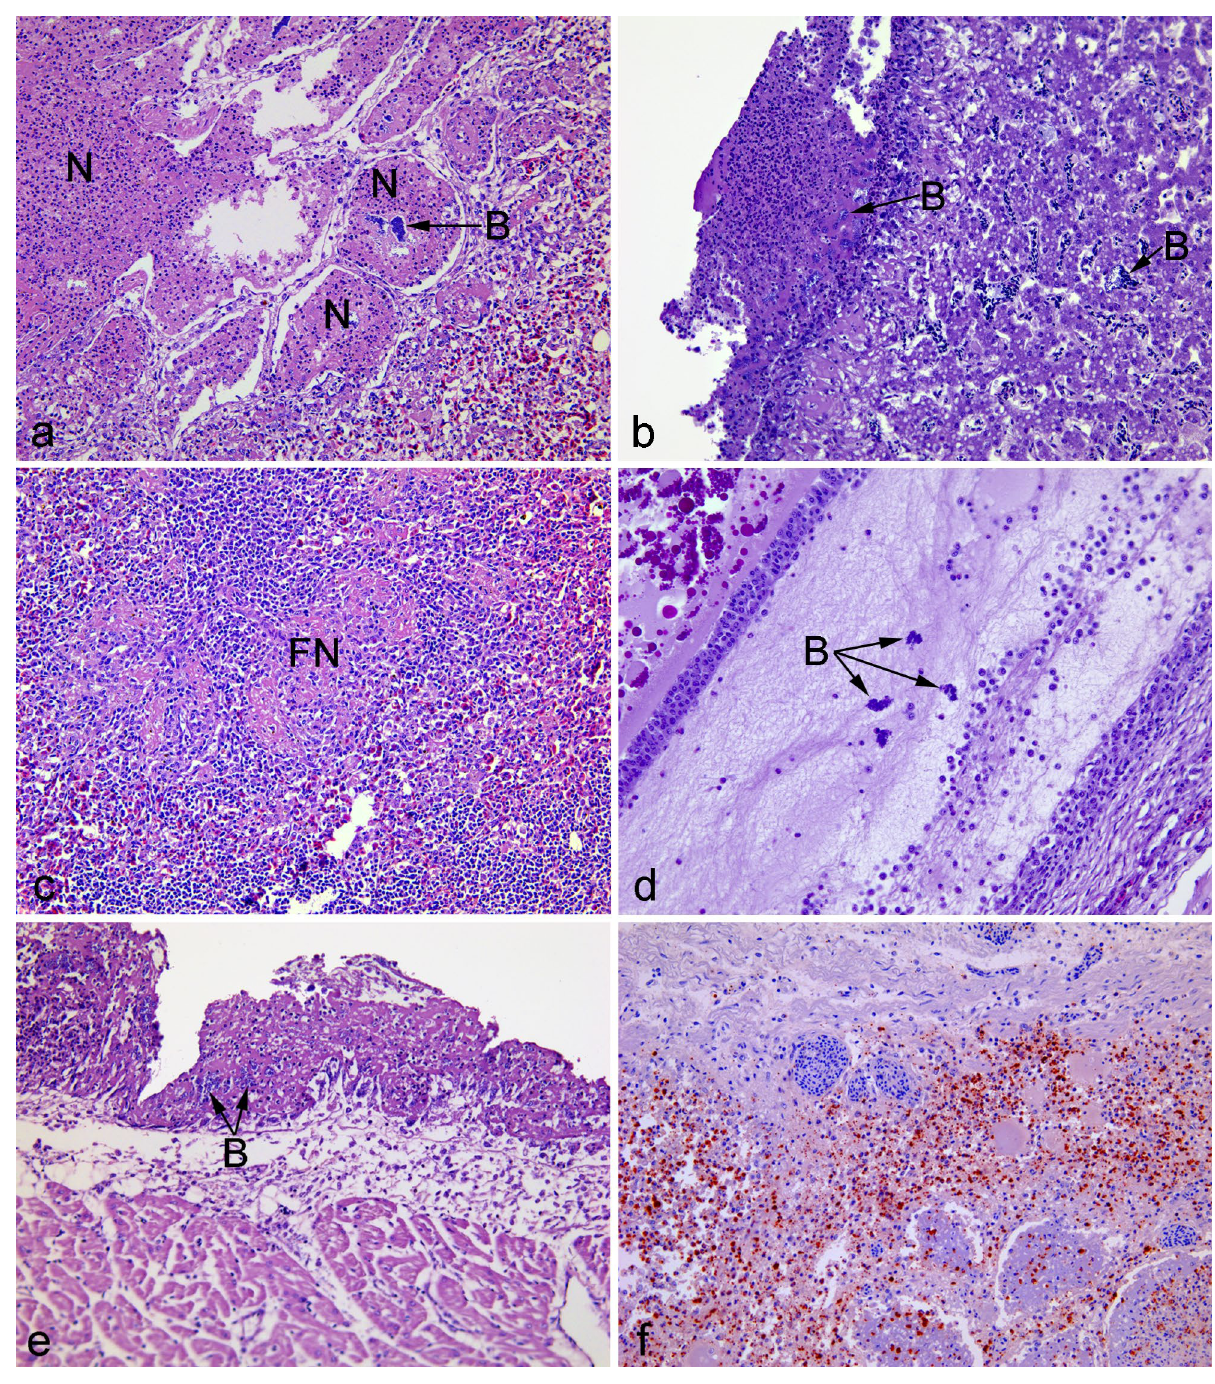
Figure 6. Histopathology of lesions. ( a ) Pulmonary section from an aerosol inoculated animal at 2 dpi displaying prominent masses of fibrinoheterophilic material and necrotic debris within the parabronchial lumen, atriae and infundibulae (N). Intralesional dense-staining bacteria are present (B). The capillary bed appears congested. ( b ) Perihepatitis and subcapsular necrosis in an aerosol inoculated bird. The surface of the liver is covered by a layer of fibrin intermixed with cellular debris and intralesional bacteria (B). A prominent capsular reaction is present with close gathering of histiocytes and lymphocytes. Within sinusoids of the liver, bacteria were easily identified (B). ( c ) Fibrinoid necrosis (FN) in the ellipsoids and periellipsoidal lymphocyte sheath of an aerosol inoculated bird, disturbing the appearance of these structures. ( d ) Folliculitis of an intermediate follicle from an aerosol inoculated bird. The granulosa cell layer is disintegrated and completely separated from the theca interna due to accumulation of proteinaceous fluid and fibrin containing bacterial colonies (B) and sparse amounts of heterophils. ( e ) Pericarditis in an aerosol inoculated bird characterised by a fibrinous mass, necrotic debris and intralesional bacteria (B). The epicardium is expanded by oedema and infiltration by mainly histiocytes. ( f ) Strong immunohistochemical staining of E. coli (red-brown) in the lung from an aerosol inoculated bird with necrotic areas in the lung primarily involving the parabronchi and adjacent